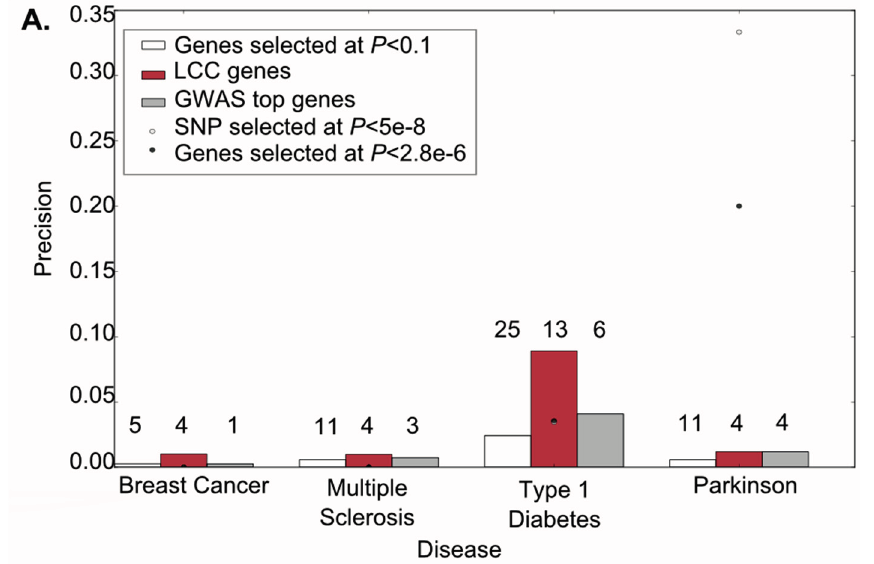
Figure 2. Largest connected components contain true biological insight into